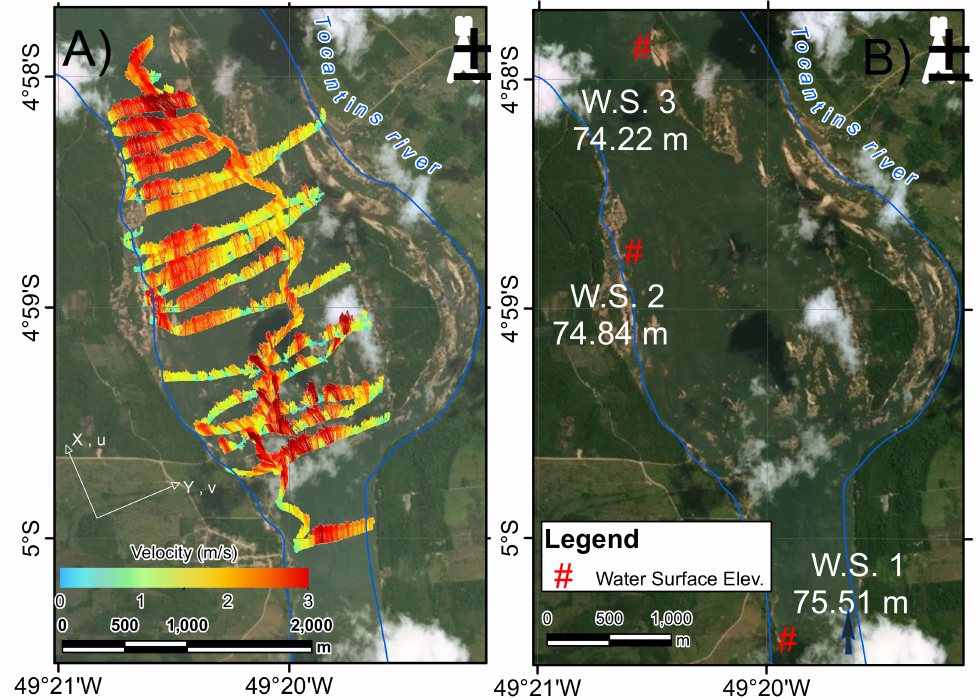
Figure 2. Measurements in Lourenço’s Rock Canyon; ( A ) ADCP trajectories with colored depth-averaged velocity vectors (April 2015); ( B ) River banks during high flow are shown in blue, and the location of the three gaging stations with measured values of the water surface elevation (April 2015) is